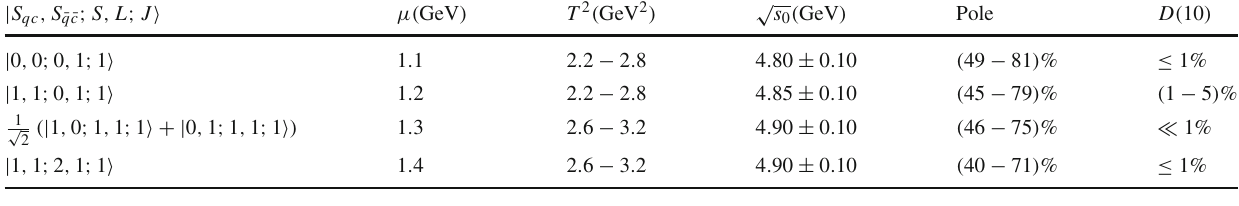
Table 4 The masses and pole residues of the vector tetraquark